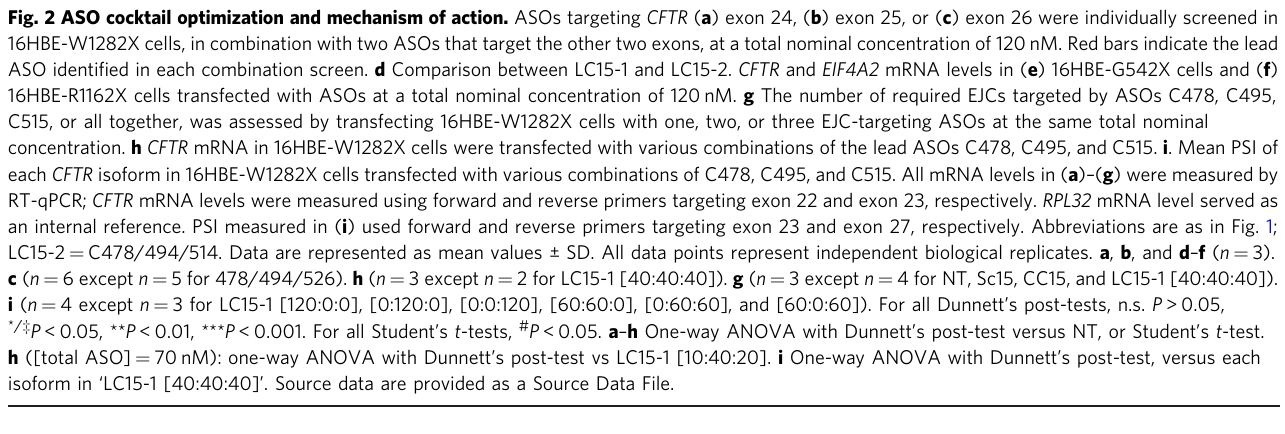
Fig. 2 ASO cocktail optimization and mechanism of action. ASOs targeting CFTR ( a ) exon 24, ( b ) exon 25, or ( c ) exon 26 were individually screened in 16HBE-W1282X cells, in combination with two ASOs that target the other two exons, at a total nominal concentration of 120 nM. Red bars indicate the lead ASO identi fi ed in each combination screen. d Comparison between LC15-1 and LC15-2. CFTR and EIF4A2 mRNA levels in ( e ) 16HBE-G542X cells and ( f ) 16HBE-R1162X cells transfected with ASOs at a total nominal concentration of 120 nM. g The number of required EJCs targeted by ASOs C478, C495, C515, or all together, was assessed by transfecting 16HBE-W1282X cells with one, two, or three EJC-targeting ASOs at the same total nominal concentration. h CFTR mRNA in 16HBE-W1282X cells were transfected with various combinations of the lead ASOs C478, C495, and C515. i . Mean PSI of each CFTR isoform in 16HBE-W1282X cells transfected with various combinations of C478, C495, and C515. All mRNA levels in ( a ) – ( g ) were measured by RT-qPCR; CFTR mRNA levels were measured using forward and reverse primers targeting exon 22 and exon 23, respectively. RPL32 mRNA level served as an internal reference. PSI measured in ( i ) used forward and reverse primers targeting exon 23 and exon 27, respectively. Abbreviations are as in Fig. 1; LC15-2 = C478/494/514. Data are represented as mean values ± SD. All data points represent independent biological replicates. a , b , and d – f ( n = 3).